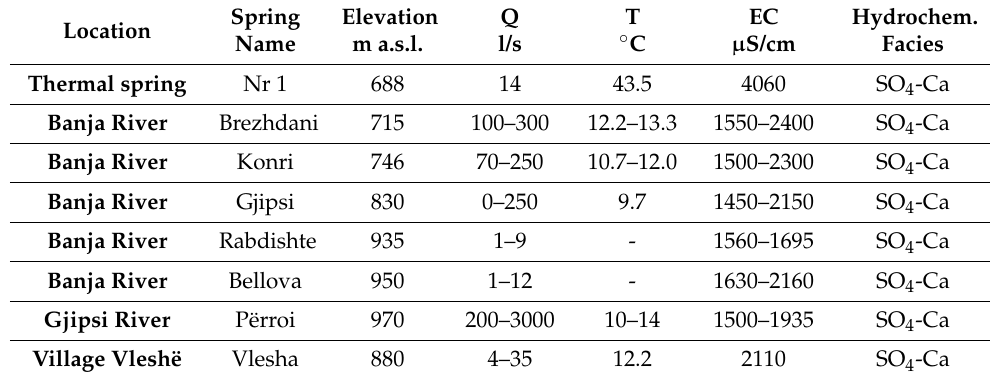
Table 2. Basic characteristics of brackish cold springs in Korab Mountain area (Figure